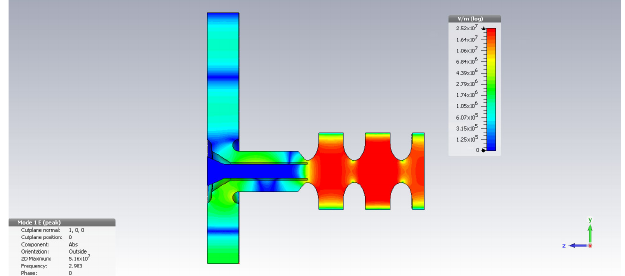
FIG. 11. rf design and CST [32] simulation of the 2.5-cell 10 Hz